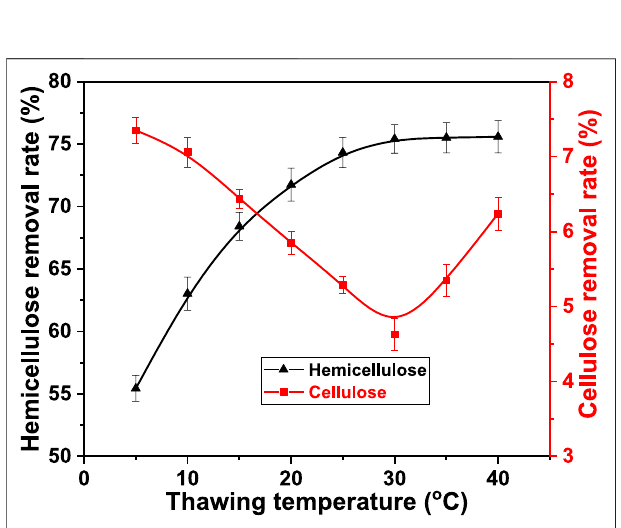
FIGURE 4 | Effect of thawing temperature on the removal rate of cellulose and hemicellulose from bagasse fi ber in